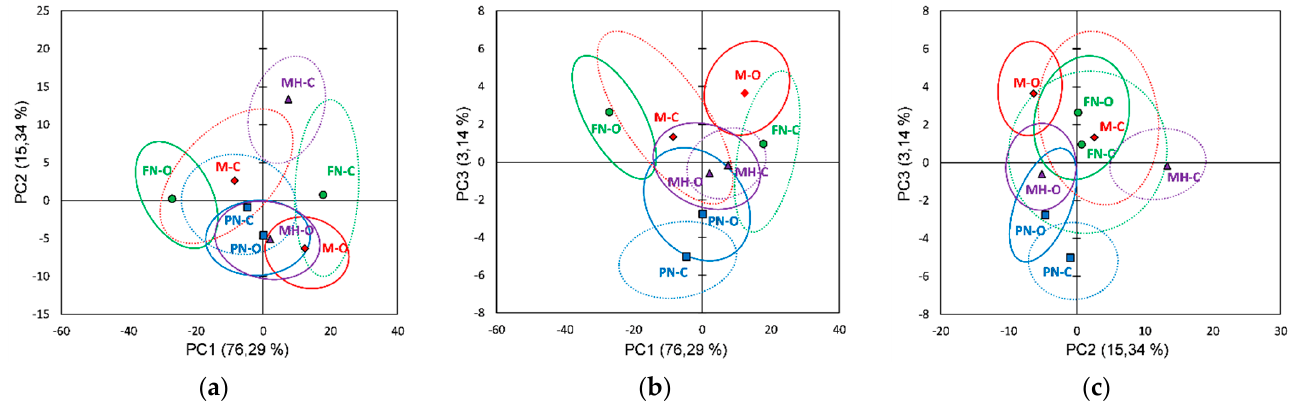
Figure 2. Score plots of the first three principal components derived from Raman data of the red grape skin extracts (the confidence ellipses are based and centered on bootstrap points): ( a ) PC1 vs. PC2 score plot; ( b ) PC1 vs. PC3 score plot; ( c ) PC2 vs. PC3 score